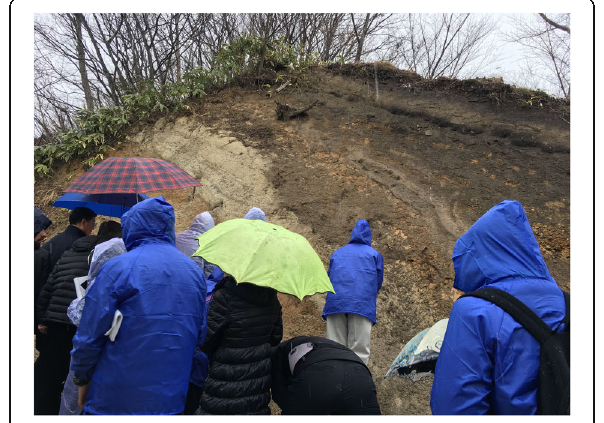
Fig. 3 Investigation at Shigaku Outcrop at the rim of the Sanbe